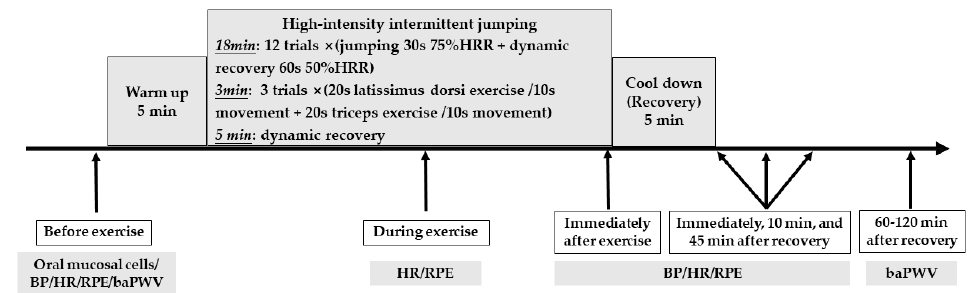
Figure 1. Experimental procedure. Note: HRR = heart rate reserve, s = seconds, BP = blood pressure, HR = heart rate, RPE = rating of perceive exertion, baPWV = brachial-ankle pulse wave velocity.